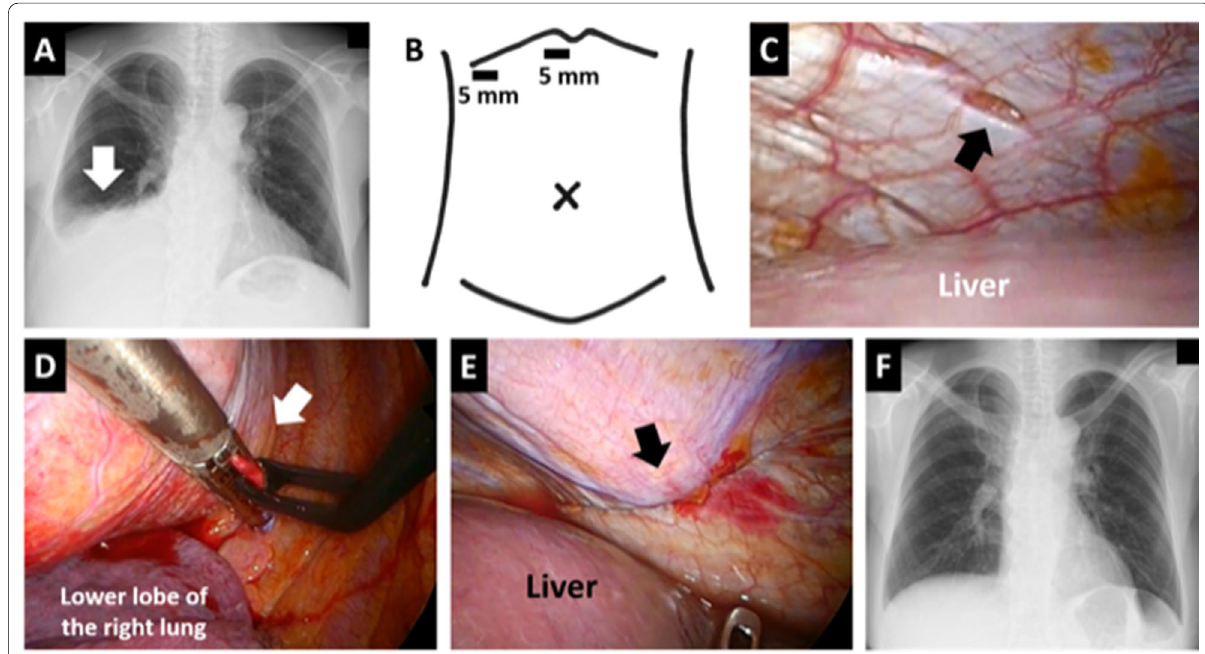
Fig. 1 Diagnosis and treatment for pleuroperitoneal communication in Patient 1. A Chest radiograph taken 2 months after the introduction of peritoneal dialysis. An arrow shows right pleural effusion. B . Port positions in the laparoscopic approach. C Laparoscopic view of the diaphragmatic fistula. An arrow shows a 2-mm-sized fissure in the central tendon of the right diaphragm over the liver. D A thoracic view of the closure of the diaphragmatic fistula using an automatic suture device. An arrow shows the grasped site of the right diaphragm, including the fistula. E Laparoscopic view of the closed site. The arrow shows the suture line. F Chest radiograph taken 3 months after the